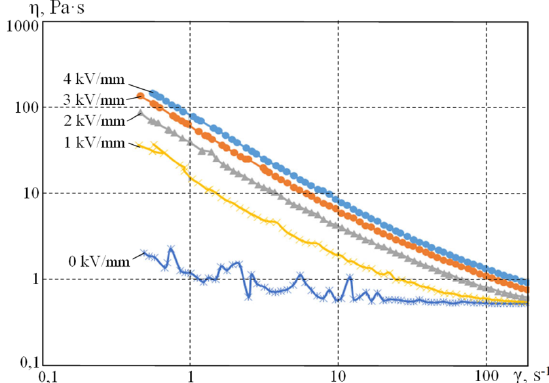
Figure 6. The dependence of viscosity on the shear rate of the suspension PI-Na .